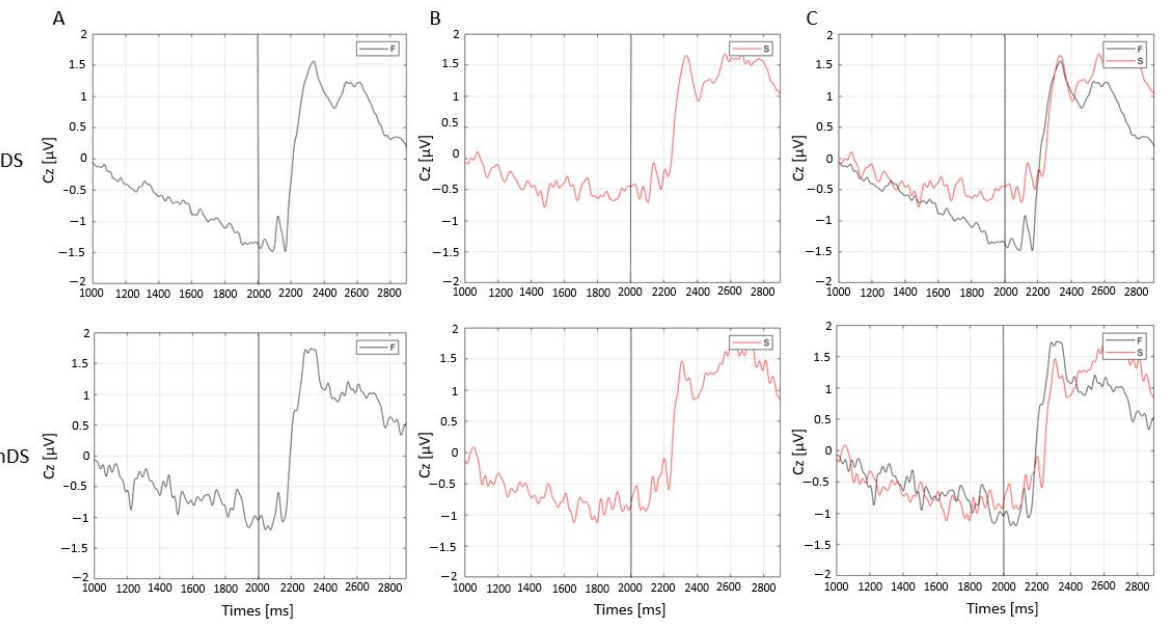
Figure 6. Contingent negative variation (CNV) trends of Cz electrodes in faster (F) ( A ) and slower (S) groups ( B ) and their overlaps ( C ) for directional (DS) (upper row) and non-directional stimuli (nDS) (lower row) conditions.